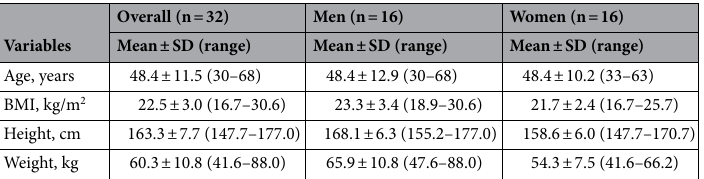
Table 2. Characteristics of the study population. BMI body mass index, SD standard deviation.